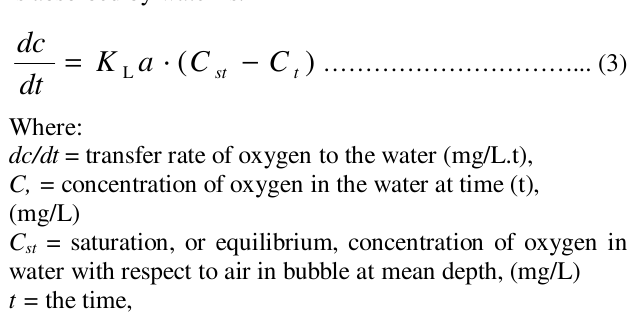
Figure 1: Schematic of diffused air aeration system For good performance the rate of supply of dissolved oxygen should be equal to the rate of oxygen consumption exerted by the mixed liquor under any given set of